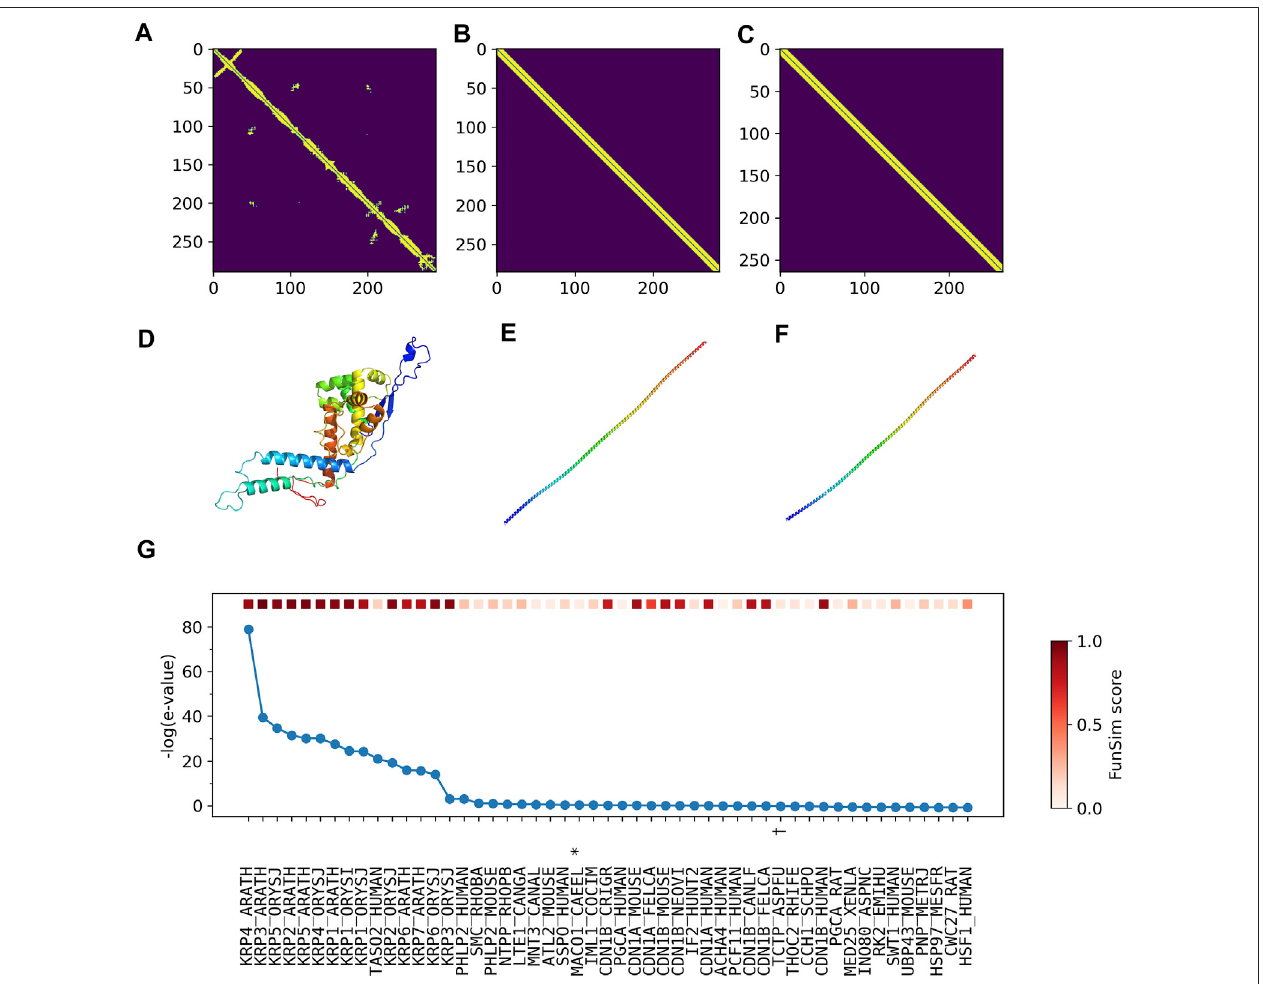
FIGURE7| IllustrationofGOtermpredictionsbyContactPFPforCyclin-dependentkinaseinhibitor4(KRP4_ARATH,Q8GYJ3).The fi rstthreepanelsarepredicted contacts for the query, KRP4_ARATH (A) , and the two most similar proteins in terms of the contact pattern, (B) TPM3_HUMAN and (C) TPM_CHAFE. The graph similarityscoresbyGR-align were0.677 and 0.673,respectively. Panel D, E,F arepredicted structures ofthesethreeproteinsbytrRosetta inthe same orderasthe fi rst row. (G) ,Thetop50hitsforthequerybyPSI-BLASTagainst Swiss-Prot. Funsimscorescomparedwiththequery proteinareshowninthetoprowinacolorscale. Themostleftcolumnisthequeryitself.TheproteinsthathaveincorrectGOtermslistedin Table5 aremarkedwithsymbols,*, “ actin fi lamentbinding ” (GO:0051015);#, “ actin fi lament organization ” (GO: 0007015); and † , “ microtubule ” (GO: